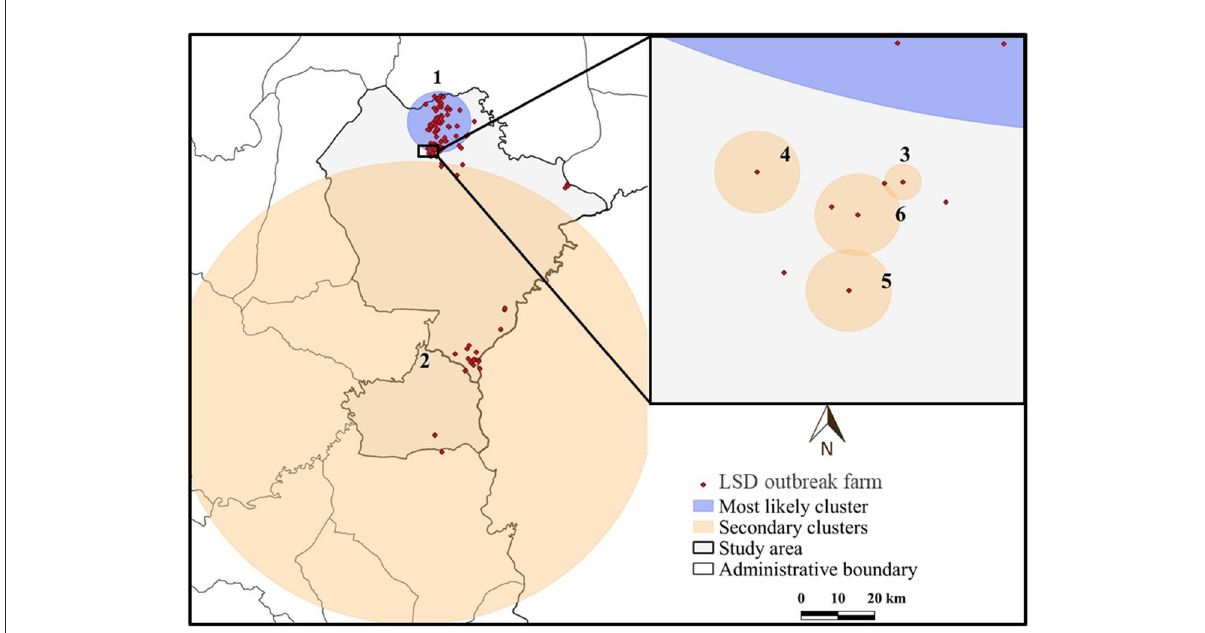
FIGURE4 Spatio-temporal clusters of lumpy skin disease (LSD) outbreaks in dairy farms, Khon Kean province, Thailand detected by the Poisson model.